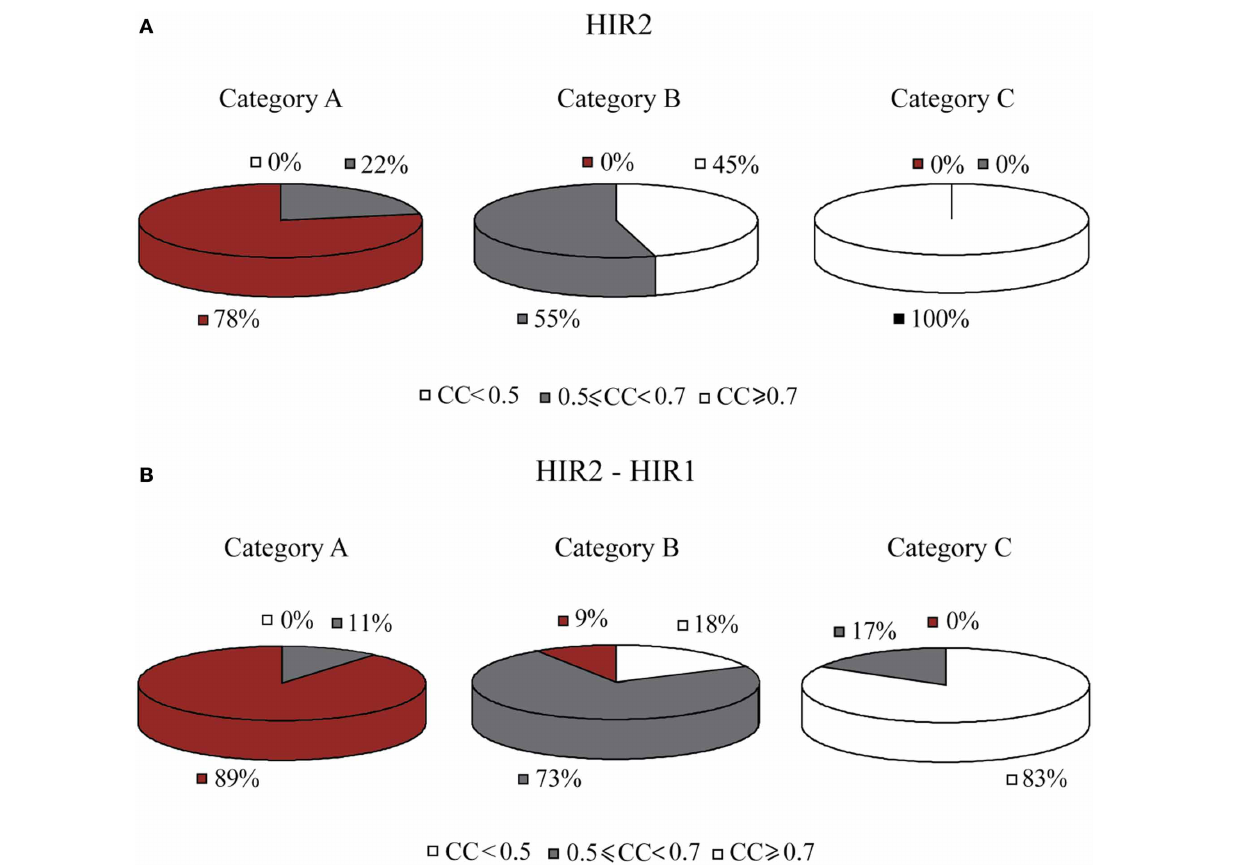
FIGURE 8 | Pie charts that show the grouped correlation coefficients (CC) of the ANN models in the three stress categories. (A) Results correspond to genes in modules regulated by HIR2 alone. ANNs with CC > 0.7 are only seen in Category A (heat shock). For Category C in